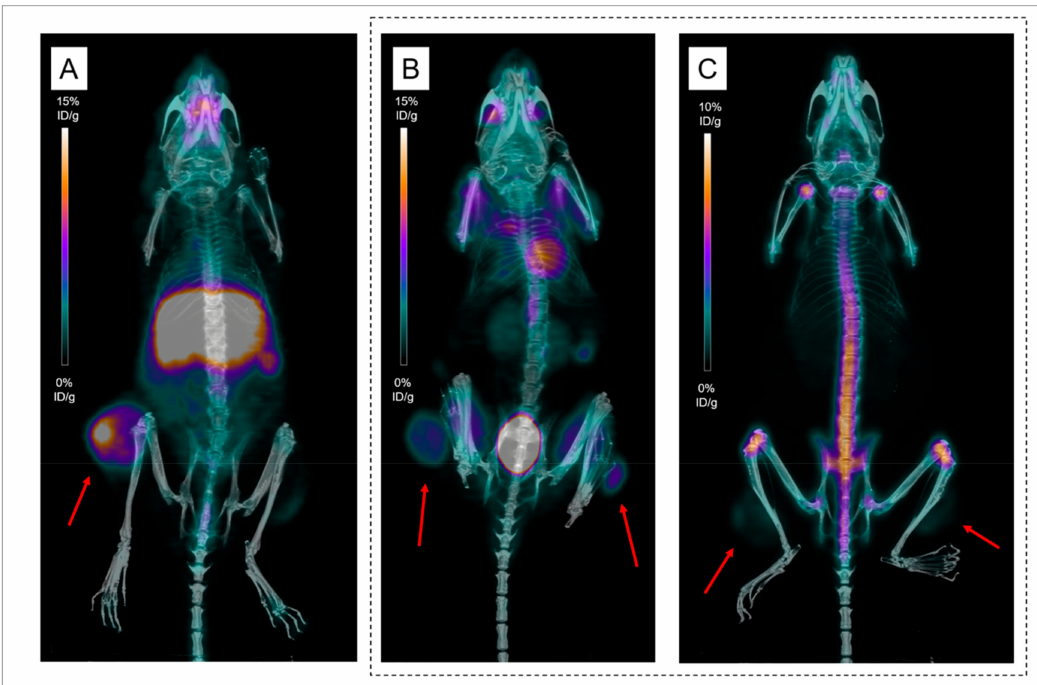
Figure 2. Positron emission tomography (PET) imaging with 89 Zr-DFO-9E7.4, 18 F-FDG-PET and 89 Zr-oxalate in tumor-bearing mice. Maximum intensity projections of PET and CT imaging at 24 h post-injection (PI) ( A ) of Mouse 1 showing uptake of a subcutaneous tumor (Tumors are indicated by red arrows). Maximum intensity projections of PET and CT imaging with 89 Zr-oxalate at 24 h PI ( C ) of Mouse 10 showing low uptakes in both subcutaneous tumors while clearly visible on maximum intensity projections of 18 F-FDG-PET and CT imaging ( B